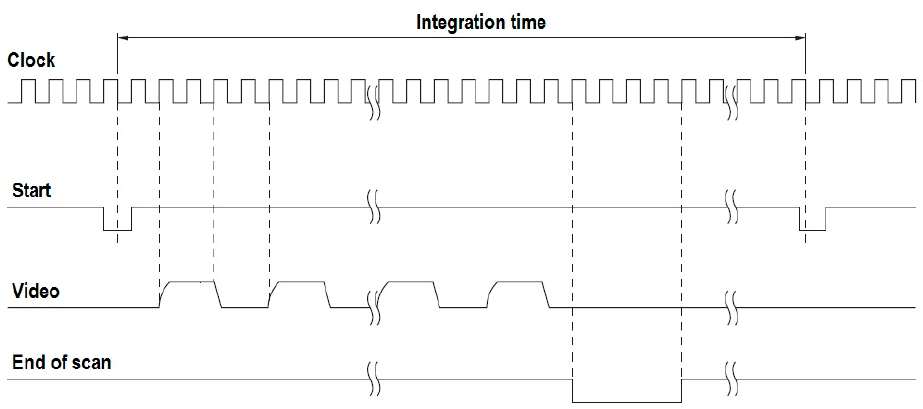
Figure 2. The MEMS theoretical timing charts [25].